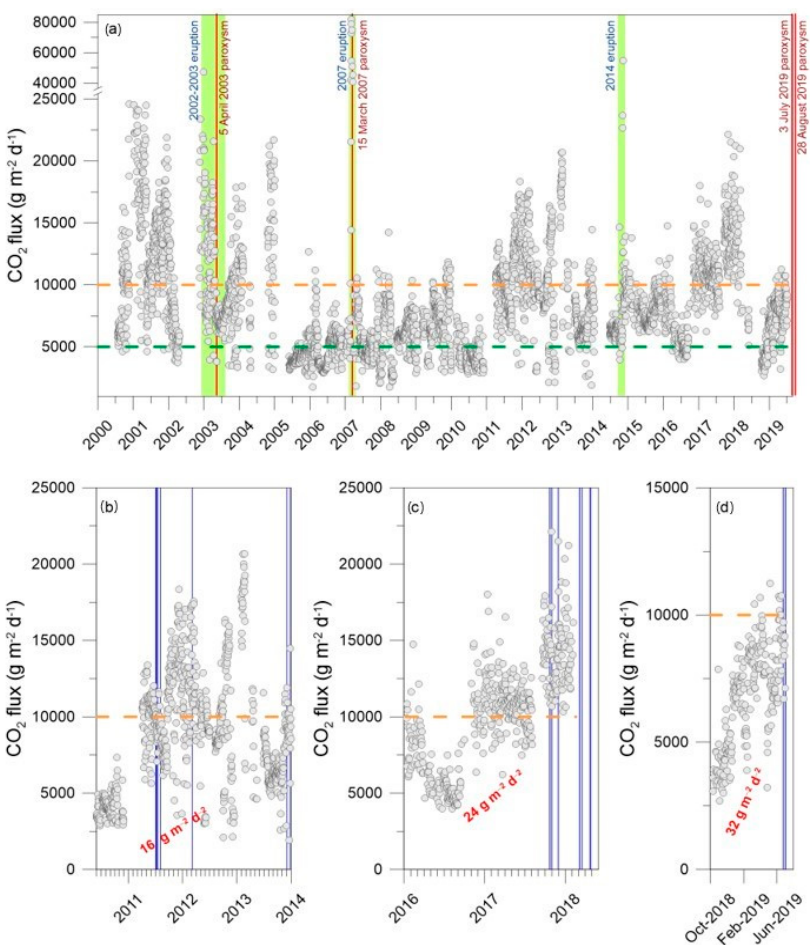
Figure 2. ( a ) Daily average CO 2 fluxes at STR02 station, 2000–2019 period. The effusive eruptions of 2000, 2007, and 2014 have been inserted (vertical green bar) together with the paroxysmal events (vertical red lines) that occurred in 5 April 2003; 15 March 2007; 3 July; and 28 August 2019. Green and orange horizontal dashed lines have been plotted indicating, respectively, the baseline values and threshold value for the CO 2 fluxes at STR02 (see [5,21,23]). The insets of the higher degassing rate periods have been plotted together with the major explosions (vertical blue lines) occurred. ( b ) Daily average CO 2 fluxes at STR02 station, June 2010–December 2013 period, with the abrupt CO 2 degassing rate of 16 g m − 2 d − 2 . ( c ) Daily average CO 2 fluxes at STR02 station, 2016–2018 period, with the abrupt CO 2 degassing rate of 24 g m − 2 d − 2 . ( d ) Daily average CO 2 fluxes at STR02 station, October 2018–June 2019 period with the abrupt CO 2 degassing rate of 32 g m − 2 d − 2 .